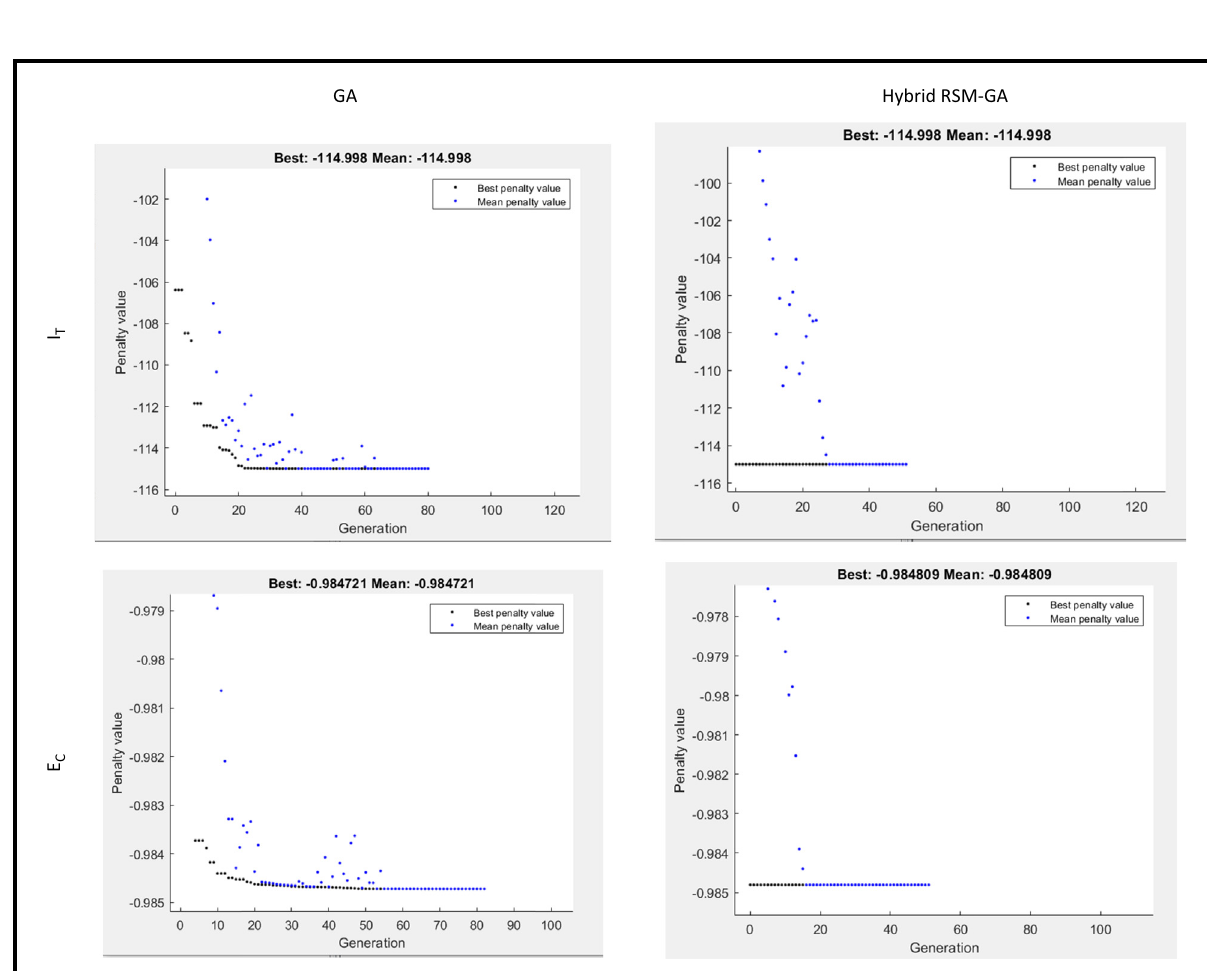
Figure 26: Optimum I T and E C by GA and hybrid RSM –